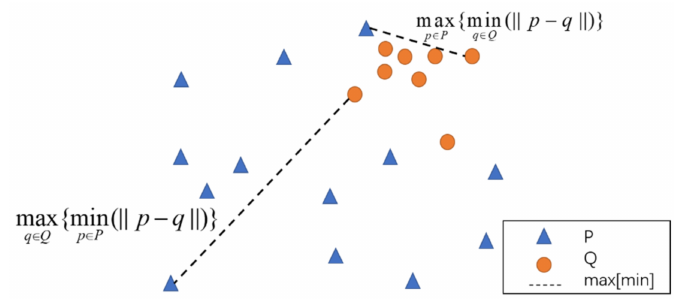
Figure 6. Diagram of Hausdorff distance calculation.